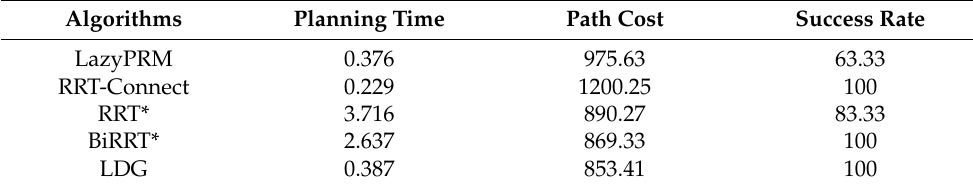
Table 1. Speed, path cost and success rate of LDG benchmarked against other algorithms in scene 1. Algorithms